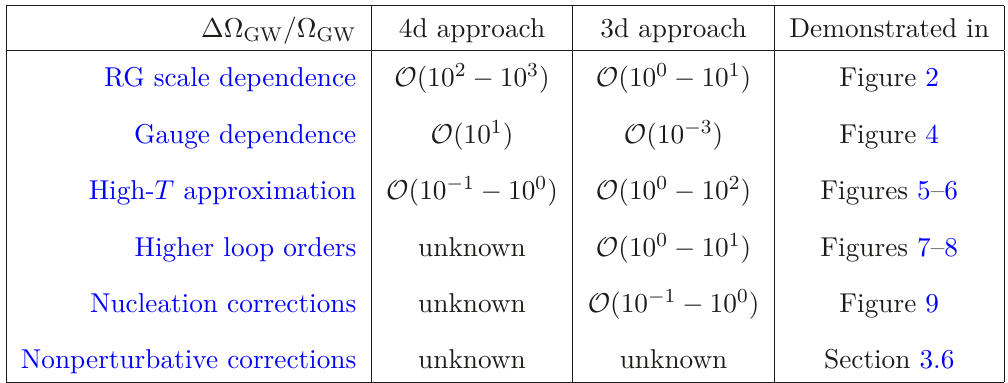
Table 3 . Sources of theoretical uncertainty and relative importance quantified by the parameter ∆Ω GW / Ω GW defined in eq. (3.1) over the range M = do not have reliable estimates for the uncertainties of the 4d approach due to higher loop orders and nucleation corrections, they are expected to be much larger than the corresponding uncertainties of the 3d approach (see the relevant